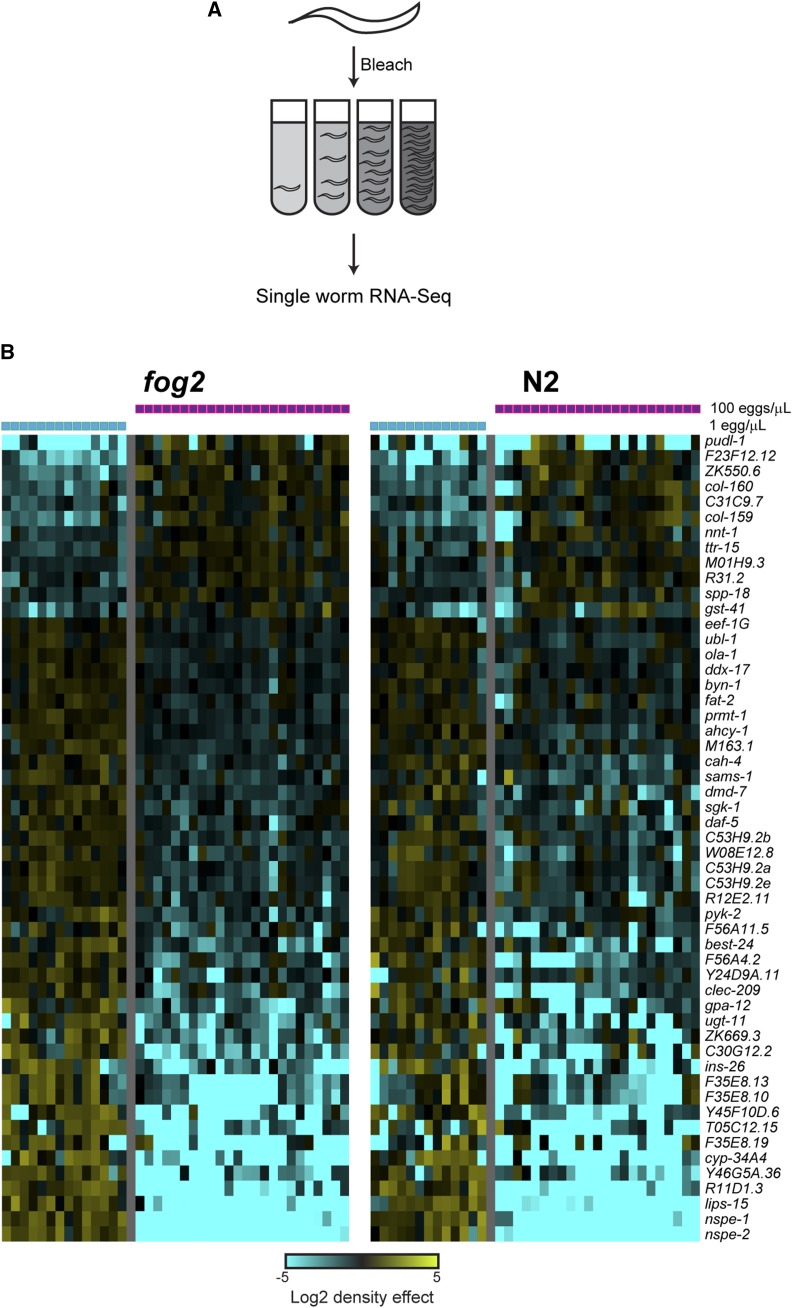
Effects of L1 arrest density on larval gene expression. A) Experimental schematic. Gravid C. elegans adults are bleached to recover a mixed population of early embryos. Embryos are then washed in M9 buffer containing PEG, counted, and resuspended at the indicated densities in 3 mL of M9. 22 hr post-bleaching, individual L1 animals were picked into separate tubes and processed for single-worm RNA-Seq. B) Significant effects of L1 arrest density on mRNA abundance. Heatmap shows clustered RNA abundance data for 53 genes significantly differentially-expressed (padj < 0.05) between 1 and 100 egg/μL cultures. Data are shown separately for replicate experiments using N2 hermaphrodites, or matings between fog-2 mutant males and “females” (genotypically XX hermaphrodites which are incapable of making sperm and therefore phenotypically female), as indicated. In both datasets, mRNA abundance for individual L1s is expressed as the log2 ratio relative to the average for that gene across all individuals in the relevant strain background.